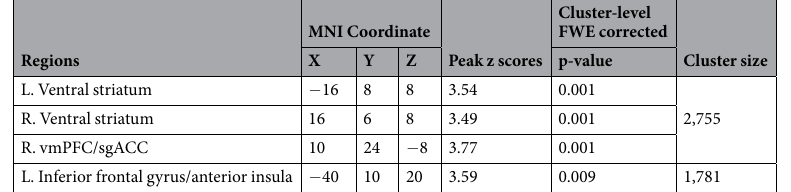
Table 2. Brain regions showing increased CBF in the post-con compared to the pre-con + con group. L, left;